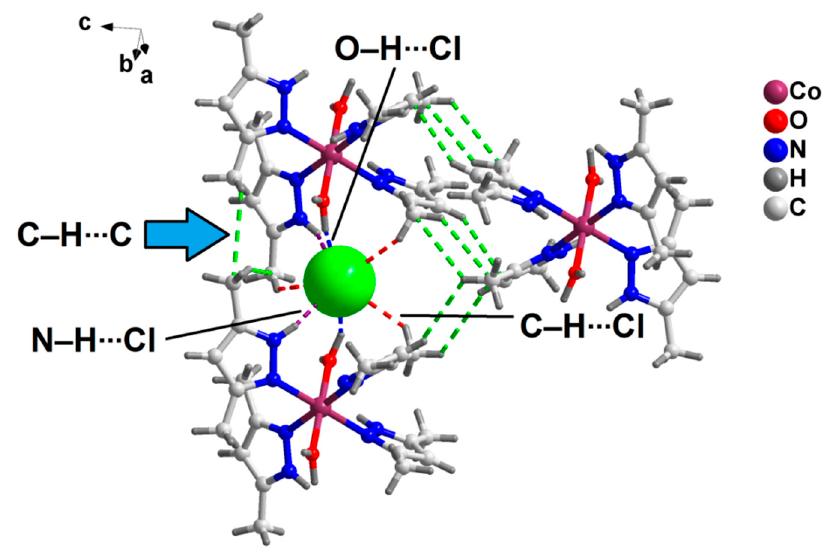
Figure 7. Enclathration of single guest chlorine atom within the supramolecular trimeric host cavity of compound 2 .